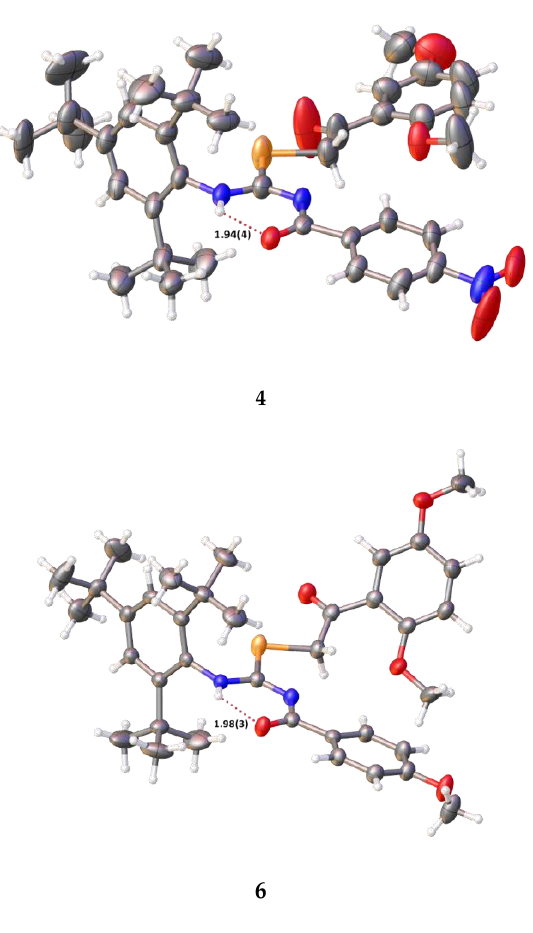
Figure 7. Strong intramolecular N–H∙∙∙O hydrogen bonding in compounds 4 (only one independent molecule shown) and 6. Atoms colors are the same as in Figures 5 and 6 except hydrogen, which is white.